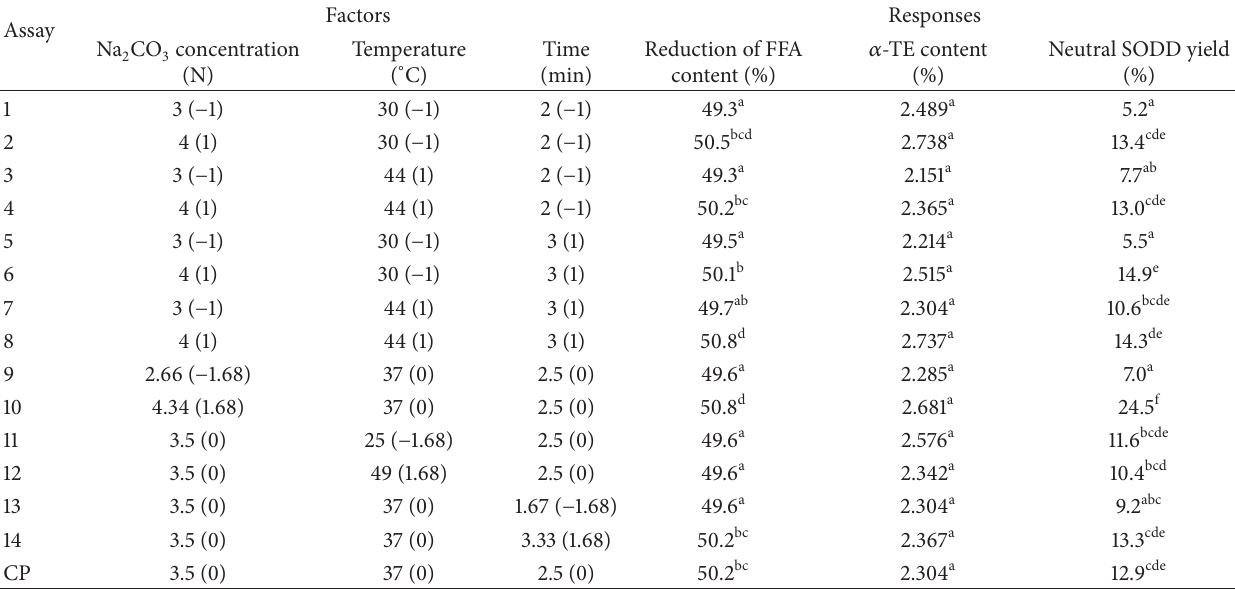
Table 3: Second experimental design matrix with real and coded variables’ values and studied